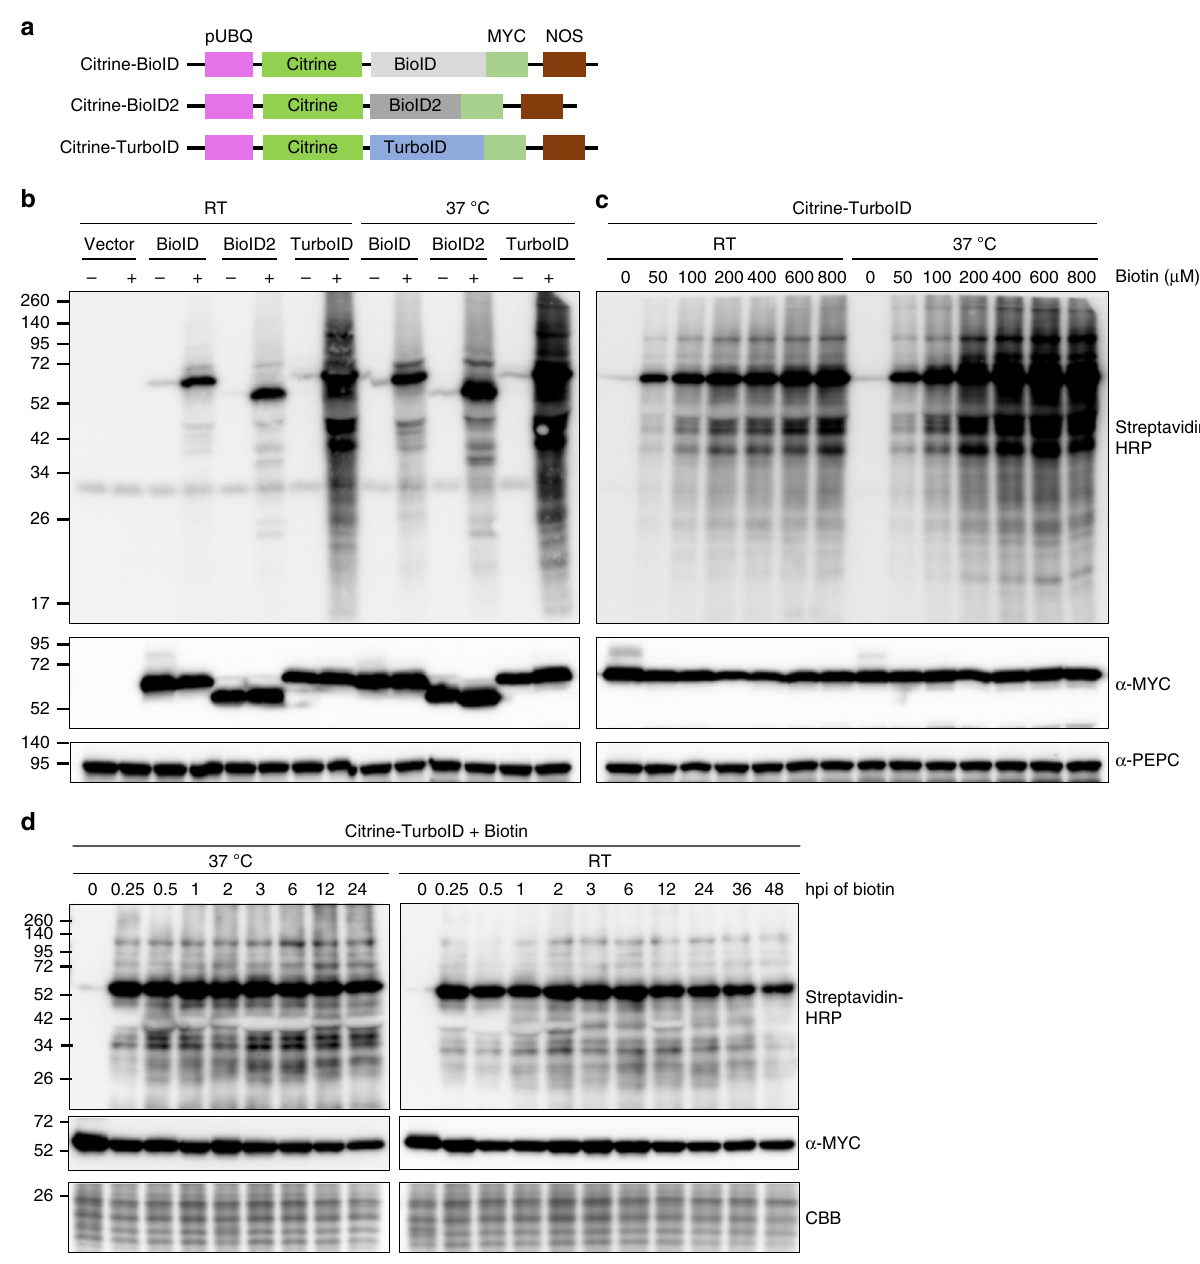
Fig. 1 Comparison and characterization of promiscuous protein biotinylation by different biotin ligases in plant. a Diagram of the expression cassettes used for the expression of three biotin ligases. Citrine was fused to the N-terminus while a MYC tag was added to the C-terminus of BioID, BioID2 and TurboID. Expression was under the control of Arabidopsis ubiquitin-10 promoter (pUBQ) and nopaline synthase terminator (NOSt). b The biotin ligases promiscuously biotinylate endogenous proteins in plant cells with varying ef fi ciencies. N. benthamiana leaves were agroin fi ltrated with the agrobacterium containing citrine-BioID-3xMYC (BioID), citrine-BioID2-3xMYC (BioID2) and citrine-TurboID-3xMYC (TurboID), or the empty vector control (vector), respectively. 36h post-agroin fi ltration (hpi), medium containing the buffer ( − ) or 200 µ M biotin ( + ) were in fi ltrated into the previously agroin fi ltrated leaves. In fi ltrated N. benthamiana plants were directly incubated at room temperature (RT) or in a 37°C chamber. Western blot analysis was performed on tissue collected 12h after in fi ltration of biotin. Streptavidin-HRP and anti-MYC antibodies were used for detection of biotinylated proteins (top panel) and different biotin ligases (middle panel), respectively. PEPC served as loading control for equal protein loading (bottom panel). The molecular weight size markers in kDa are indicated at the left of each panel. An additional repeat of this experiment is shown in Supplementary Fig. 1b. c Determination of the optimal biotin concentrations required for TurboID-based proximity labeling in planta . Different concentrations of biotin, as indicated above the panels, were in fi ltrated into the N. benthamiana leaves expressing the citrine-TurboID. These plants were then incubated in the 37°C chamber or at room temperature (RT) for 8h followed by western blot analysis as described in ( b ). PEPC served as loading control for equal protein loading (bottom panel). The molecular weight size markers in kDa are indicated at the left of each panel. Additional repeat of this experiment is shown in Supplementary Fig. 1c. d Effect of incubation time on TurboID-based proximity labeling in plants. N. benthamiana leaves expressing citrine-TurboID were in fi ltrated with 200 µ M biotin, plants were then incubated under 37°C or RT followed by collection of leaves at different time points as indicated above the panels. Western blot analysis was then carried out as described in Fig. 1b. Due to the instability of rbcL protein levels at different time points after biotin treatment (Supplementary Fig. 2), the protein bands below that of the rbcL in the Coomassie Brilliant Blue (CBB)-stained gel is shown as a loading control (bottom panel). The molecular weight size markers in kDa are indicated at the left of each panel. Source data are provided as a Source Data fi